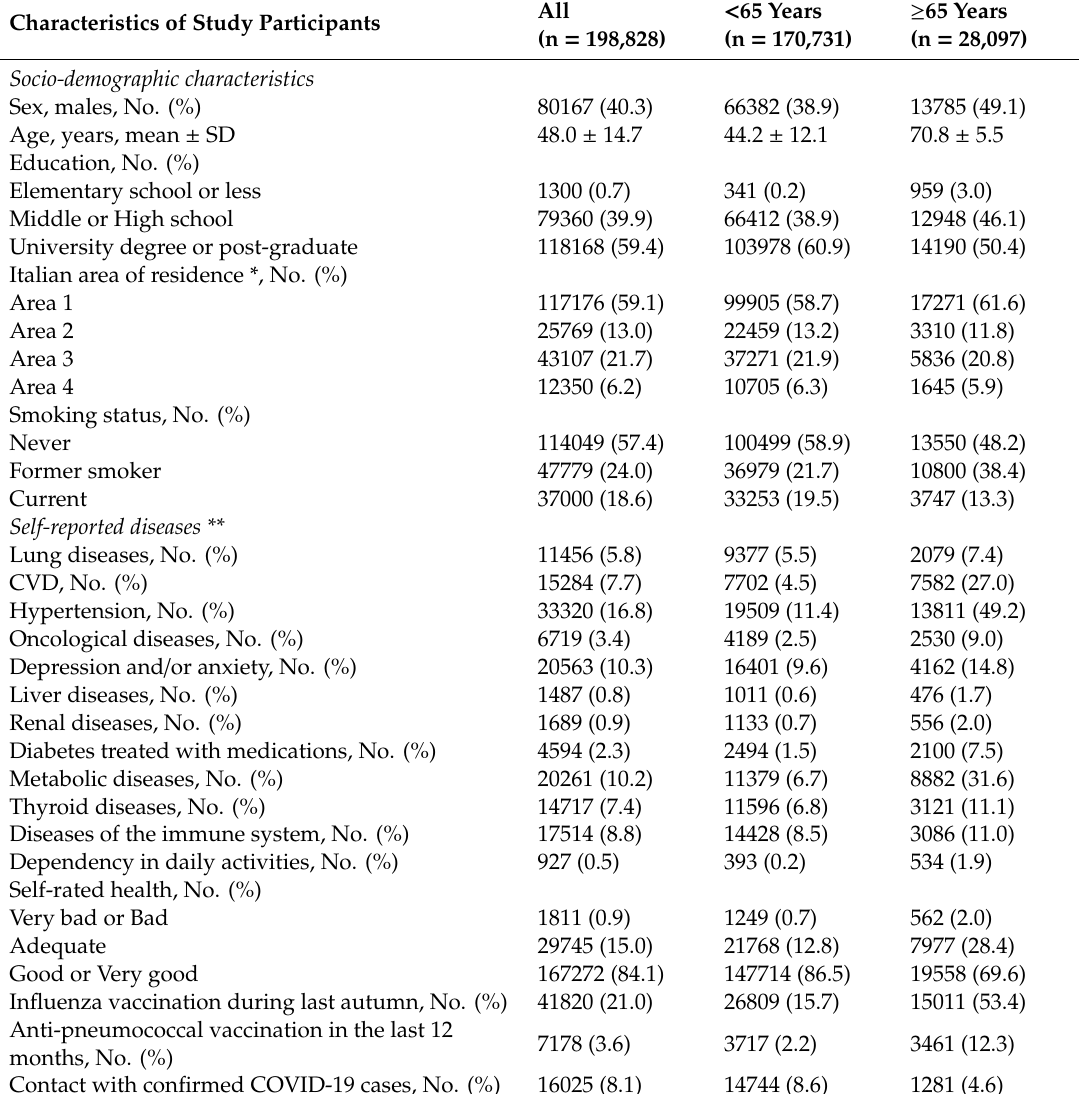
Table 1. Characteristics of study